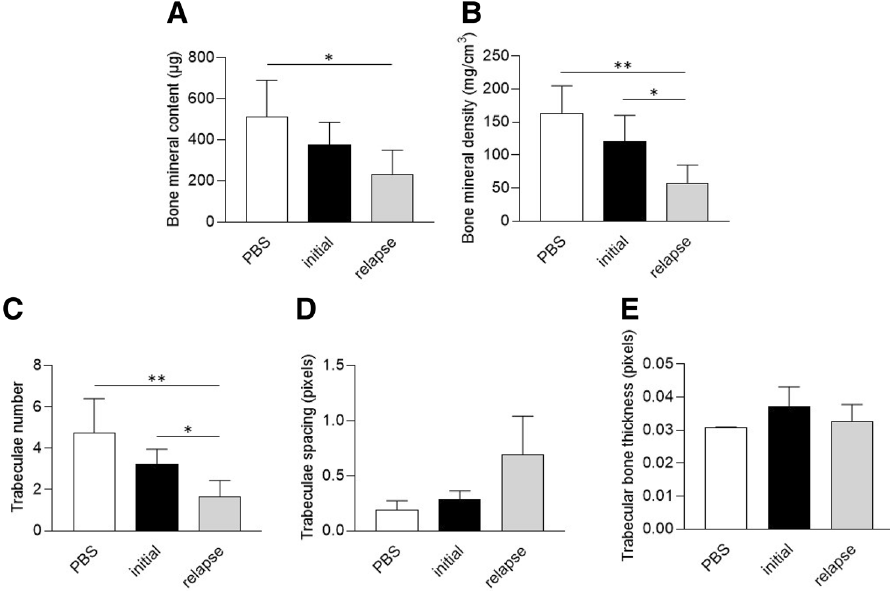
Figure 4. Effect of S. aureus clinical strains (initial and relapse) on the trabecular bone in vivo after 7 days of infection. Mice were infected at the midfemur using a clinical strain isolated during the initial (Initial, n = 5) or relapse phase of a bone infection (Relapse, n = 5) or PBS injection as control (PBS, n = 3). After microtomography and 3D reconstruction, the following parameters were quantified: bone mineral content in µg